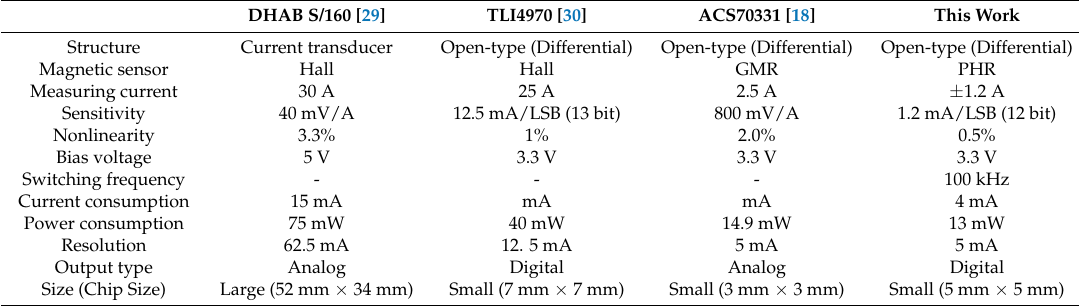
Table 2. Performance comparison to commercial